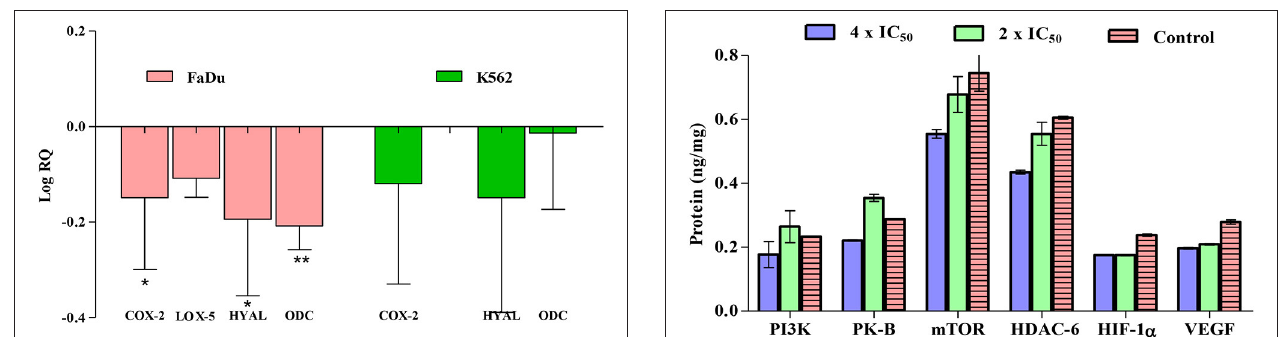
FIGURE 5 | Carvacrol effects were examined on phosphotidyl inositol-3 kinase (PI3K)/protein kinase B (AKT)/mammalian target of rapamycin (mTOR), histone deacetylase (HDAC)-6, vascular endothelial growth factor (VEGF)/HIF-1 α in FaDu cell line. FaDu cells were treated with carvacrol, radioimmuno precipitation assay (RIPA) buffer was used to extract crude protein, and the ELISA kits were used to analyse its inhibitory activity. The effect of carvacrol was non-significant on these targets.